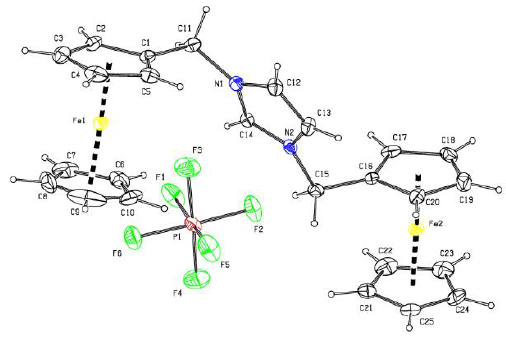
Figure 1. Molecular structure of di(ferrocenylmethyl)imidazolium salt 2 .